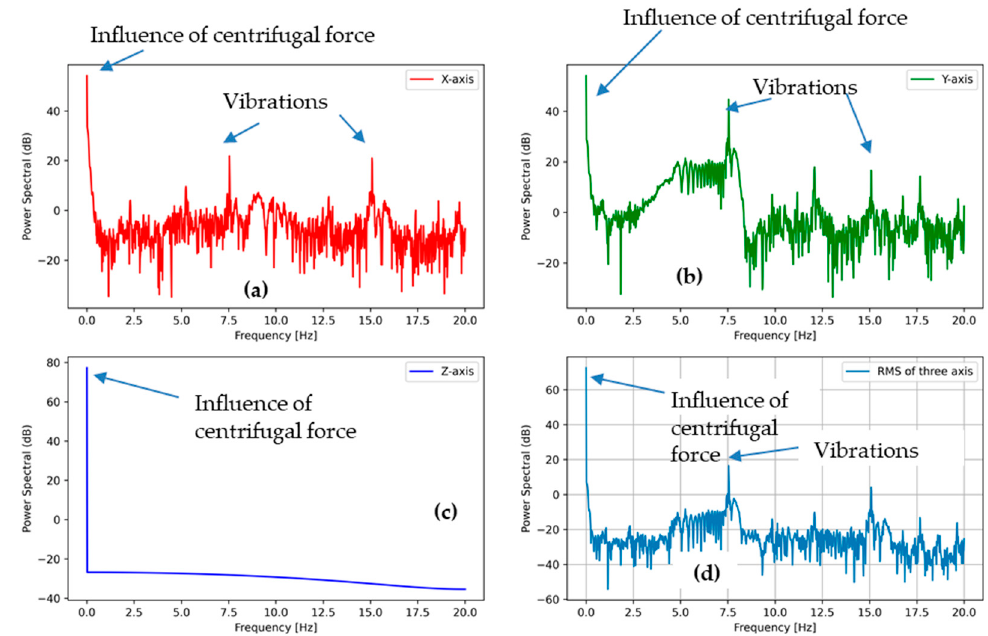
Sensors 2021 , 21 , x FOR PEER REVIEW Figure 13. PSD of the accelerometer outputs from the tumble phase (400 RPM) (after removing initial acceleration phase) ( a ) in the X direction, ( b ) in the Y direction, and ( c ) in the Z direction, ( d ) the sum of all the accelerations.